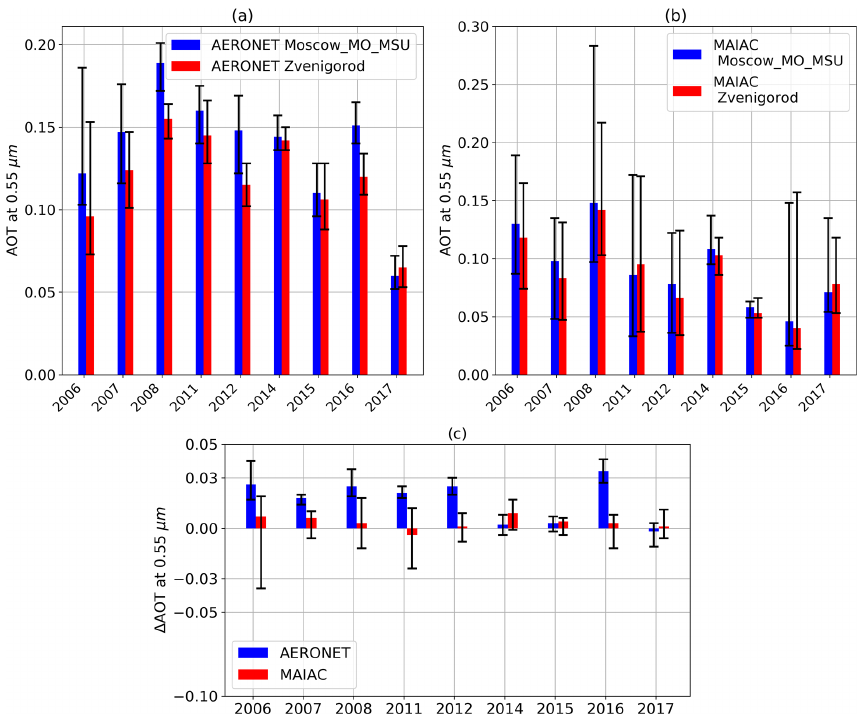
Figure 8. (a) Year-to-year variations of May–September AOT at 0.55µm medians (a) according to all matching AERONET Moscow_MSU_ MO and Zvenigorod data ( N = 1492), (b) according to the MAIAC data ( N = 264), and (c) (cid:49) AOT according to matching datasets. Error bars are given at the 95% confidence level.